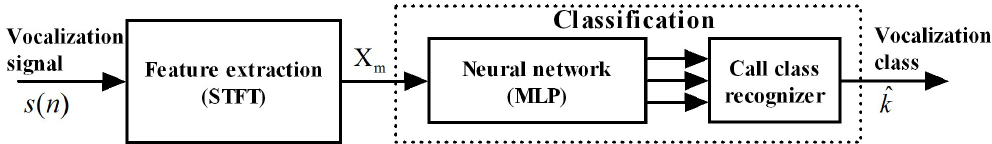
Figure 2. Block diagram of a typical classification system based on short-time Fourier transform (STFT) and multilayer perceptron (MLP) neural network.